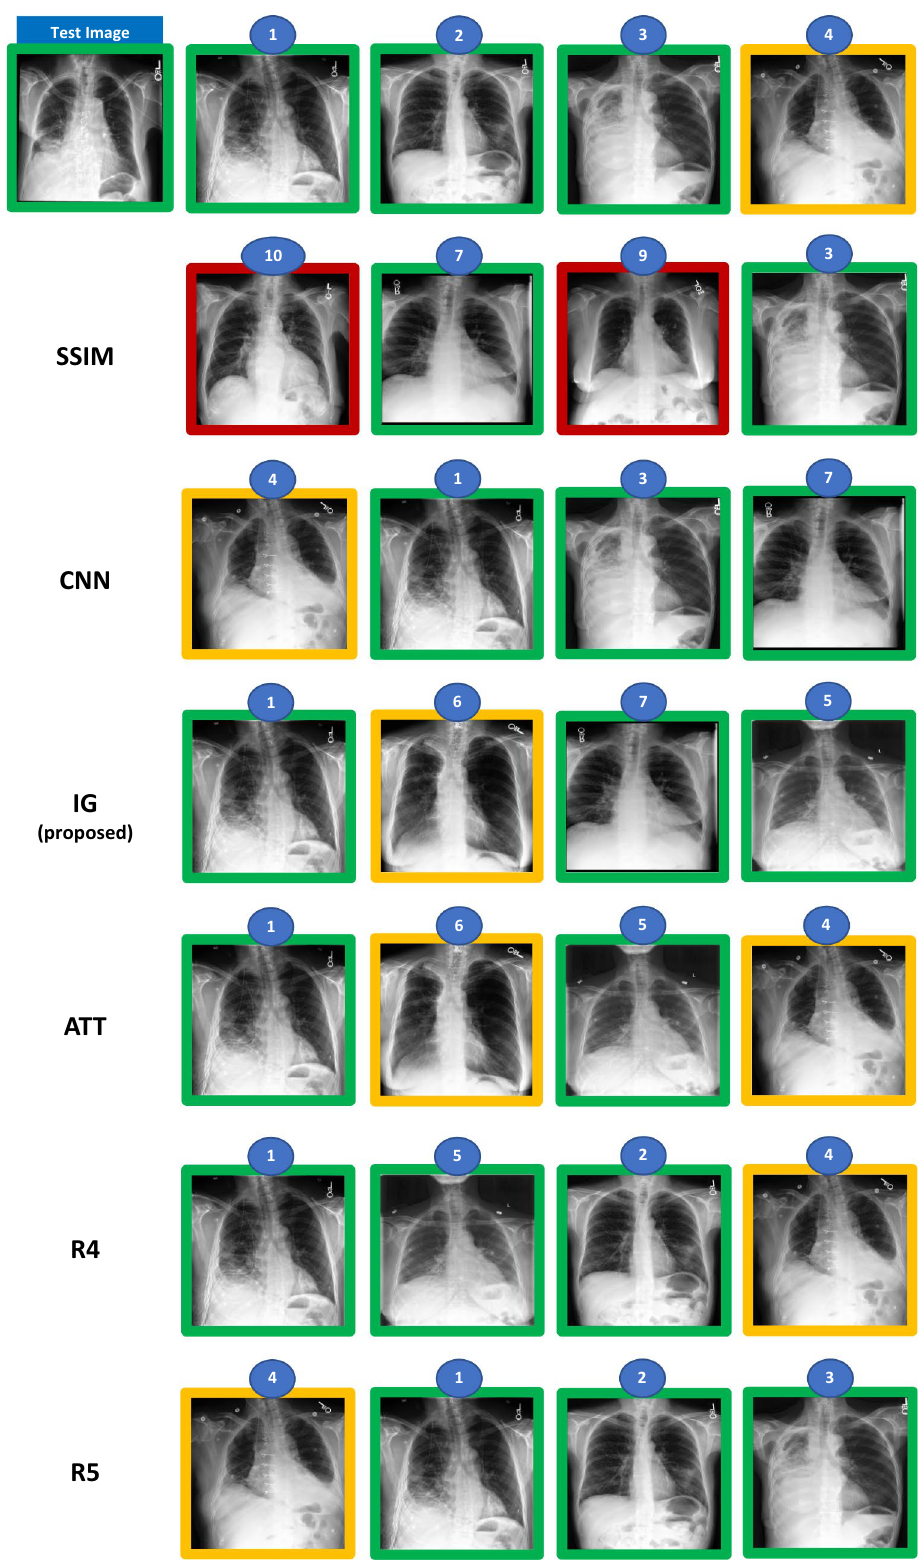
Figure 8. Example of test case and the Top-4 retrieved images given by each of the radiologists (R1 = ground- truth, R4, and R5) and each of the machine learning methods. In this split, both the CNN, IG, and ATT obtained nDCGs (Top-10) > 0.8. The green box means potential pneumonia case, red box means no potential pneumonia, and orange box means disagreement between R1 and label, with R1 considering the case as potential